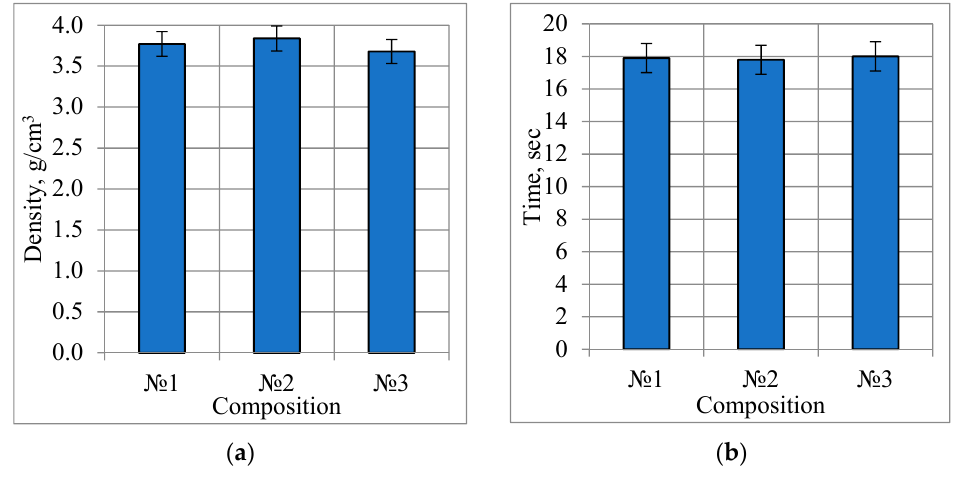
Figure 8. Bulk density ( a ) and fluidity ( b ) of powders.